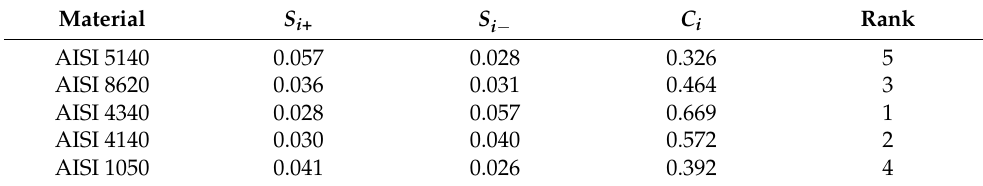
Table 13. TOPSIS Rank result.